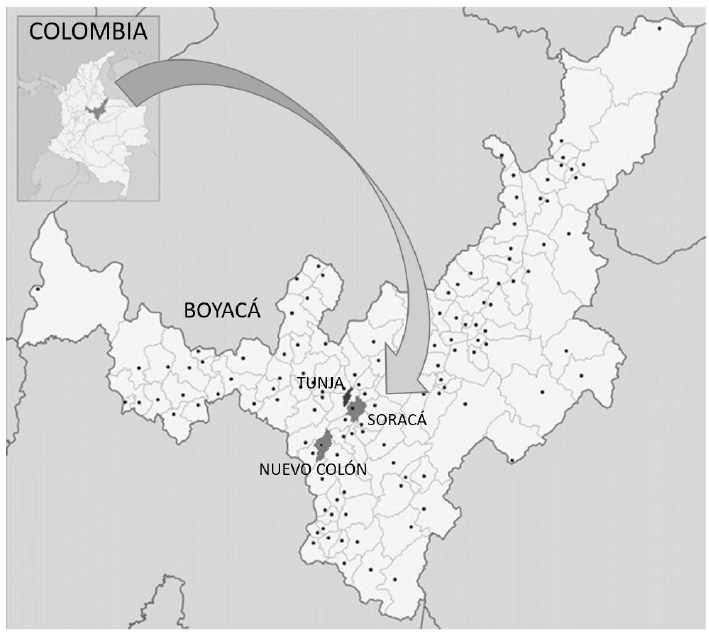
Figure 1. Study area. The municipalities of Soracá and Nuevo Colón in the Department of Boyacá, Colombia, South America. Adapted from Wikimedia Commons [26].